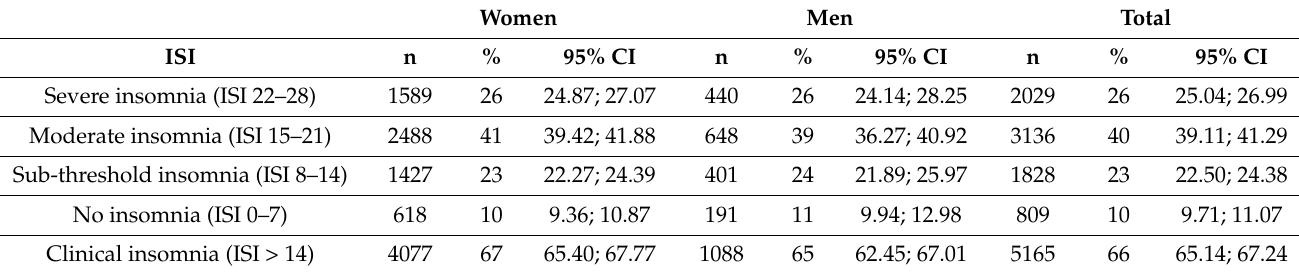
Table 2. Prevalence of insomnia in the study group at baseline ( n = 8515), classified into four categories according to the Insomnia Severity Index (ISI). Confidence intervals (CI) were calculated with the Wilson